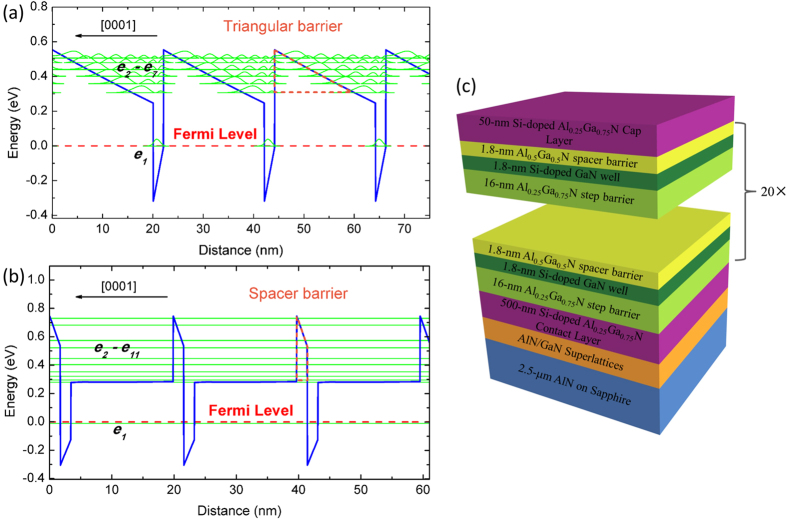
(a) Conduction band profile of Al0.35Ga0.65N/GaN (20 nm/2 nm) multiple-QWs and the triangular barrier (orange dashed line). (b) Conduction band profile of Al0.5Ga0.5N/GaN/Al0.25Ga0.75N (1.8 nm/1.8 nm/16 nm) step-QWs designed for B-to-QC ISBT and the spacer barrier (orange dashed line). (c) Schematic image of the designed sample structure.